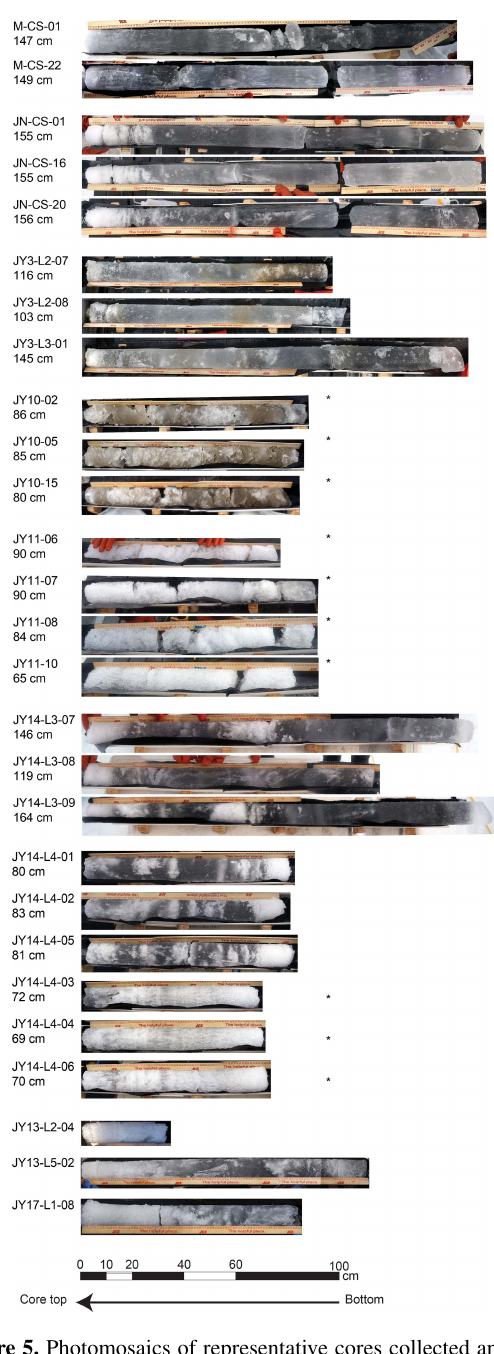
Figure 5. Photomosaics of representative cores collected and ana- lyzed in this study showing the sequence of rot. Core names corre- spond to samples discussed elsewhere in this paper and are coded by sample site (as shown in Fig. 1). The measured ice thickness at each core hole is indicated. For the JY14 samples, measured core length is indicated instead of ice thickness. Due to variability in the ice bottom, spreading or compression of weak layers, and artifacts of image stitching, core images, which are shown to scale, may not match the measured ice thickness. Asterisks ( ∗ ) indicate cores col- lected from submerged ice. Note the brown algal bloom layer visi- ble in the bottom of the May core and faintly visible at the bottom of the June core and the bright layer of retextured snow at the top of the June cores.